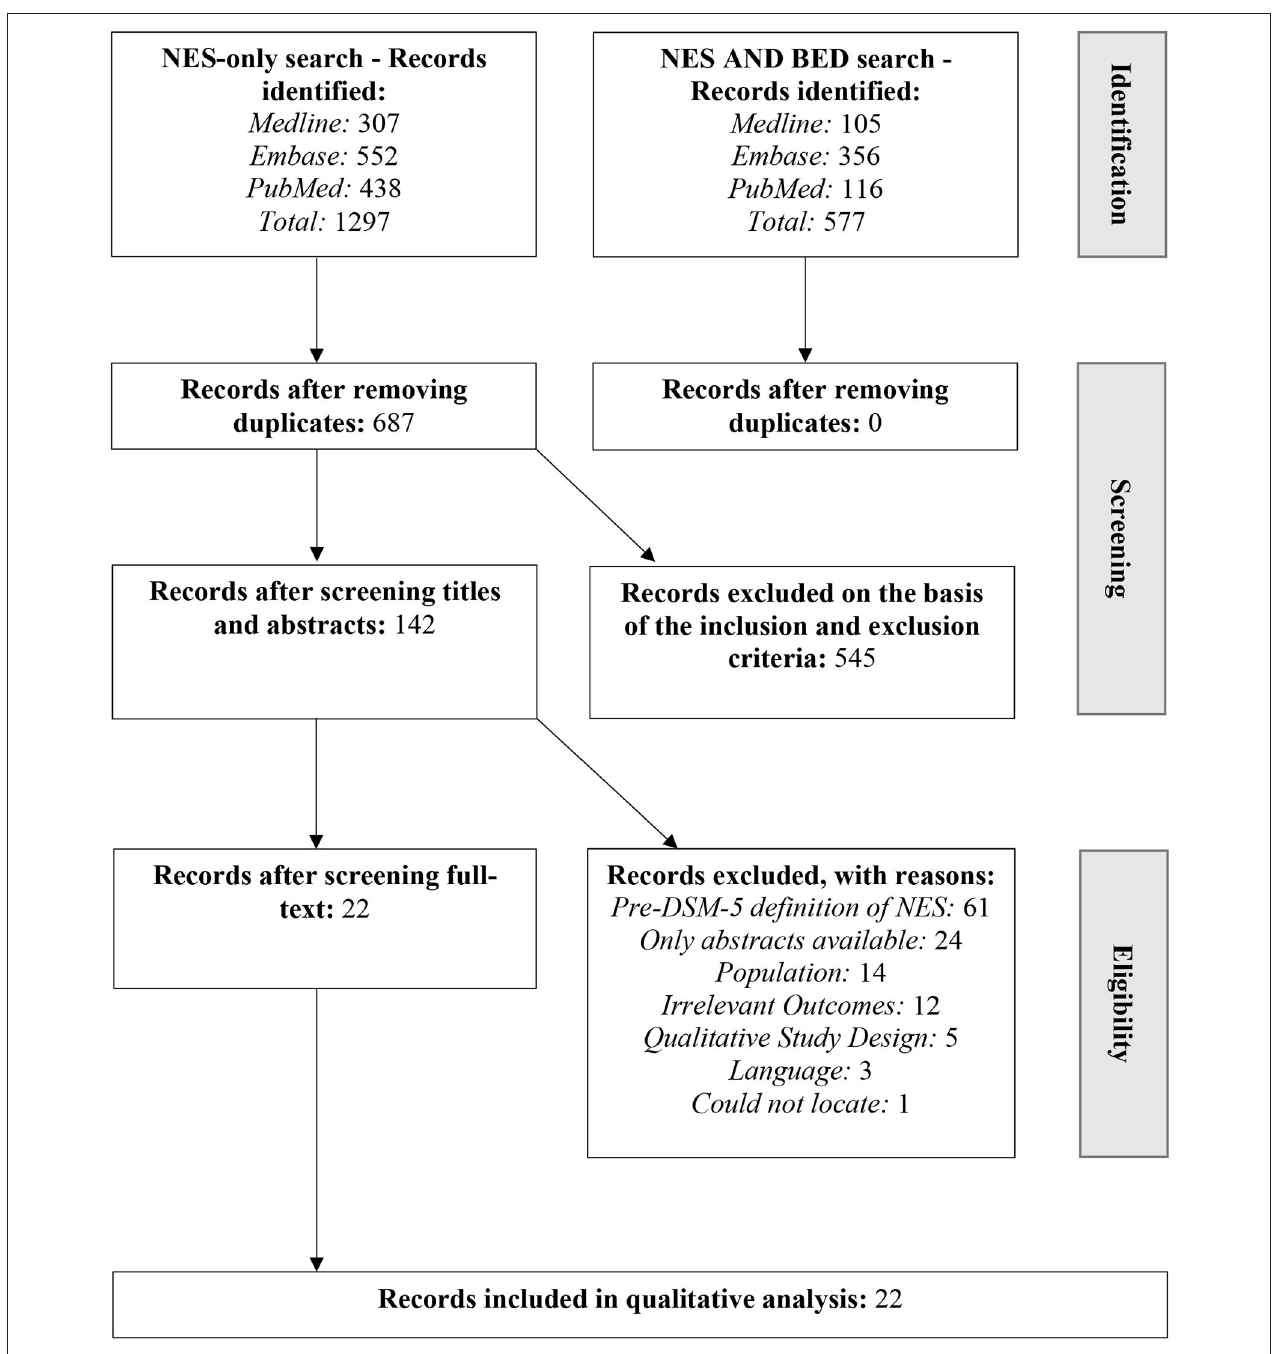
FIGURE 1 | PRISMA flow chart for selection of studies for the systematic